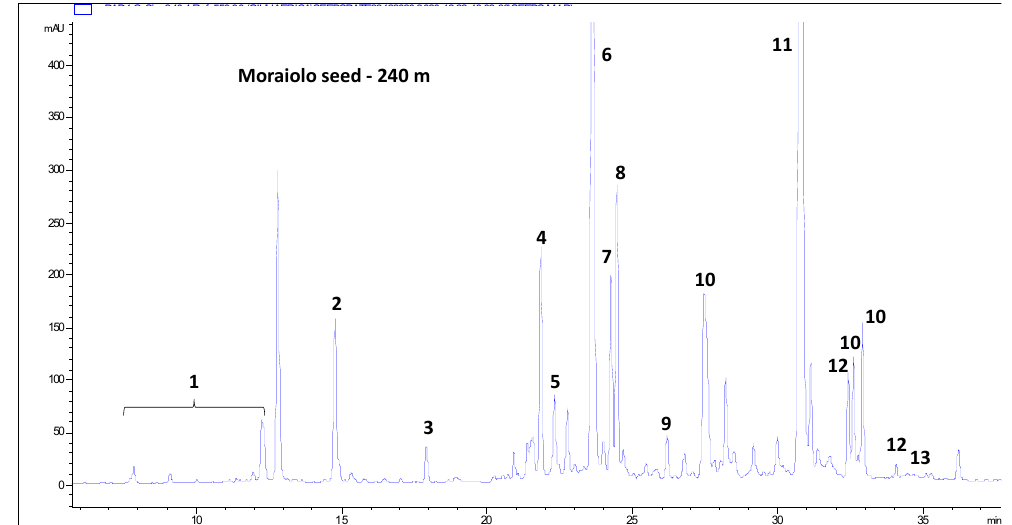
Figure 3. Chromatographic profile at 240 nm of the phenolic compounds in seeds of the Moraiolo cultivar at the fourth sampling date. 1, tyrosol derivatives; 2, oleoside 11-methyl ester; 3, oleoside 11-methyl ester isomer; 4, nüzhenide derivative; 5, verbascoside; 6, nüzhenide; 7, bis(oleoside 11- methyl ester) glucoside; 8, salidroside oleoside; 9, nüzhenide isomer; 10, nüzhenide di-(11-methyl oleoside) isomers; 11, nüzhenide 11-methyl oleoside; 12, nüzhenide di-(11-methyl oleoside) isomer 1; 13, nüzhenide di-(11-methyl oleoside) isomer 1; 14, ligstroside oleoside.